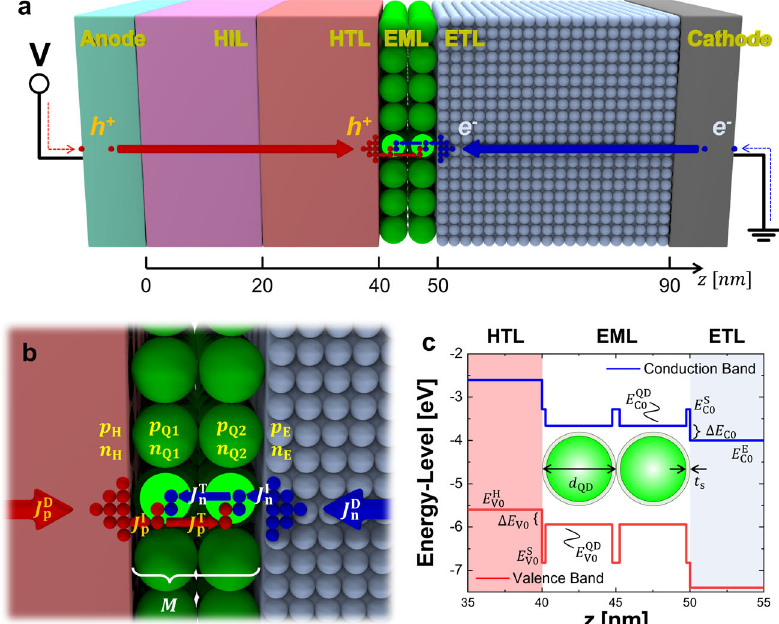
Fig. 1 Device con fi guration of QD-LED for the charge transport simulation. a Schematic illustration of device architecture. An indium tin oxide (ITO), a poly(3,4-ethylenedioxythiophene)/poly (styrenesulfonate) (PEDOT:PSS), a poly[(9,9-dioctyl fl uorenyl-2,7-diyl)-co-(4,4 ′ -(N-(4-sec- butylphenyl)diphenylamine)] (TFB), QDs, a zinc oxide (ZnO) and an aluminium (Al) are used for the anode, HIL, HTL, EML, ETL and cathode, respectively. b Schematic pathways of possible current fl ow around the EML. c Flat-band energy-level diagram across the QD-LED device. E C0QD and E V0QD are the LUMO and HOMO energy-levels of the QD core, and E C0E and E V0H are the conduction and valance band edges of ETL and HTL, respectively. E C0S and E V0S are the conduction and valance band edges of the QD shell, respectively. d QD and t s are the diameter of QD particle and the thickness of the QD shell, dependent capture process and Auger non-radiative recombina- tion are taken into account. With this simulation model, quantitative information on the distribution of charge carrier densities, electrostatic potentials, as well as radiative and non- radiative recombination rates, could be obtained. The electro- optical characteristics, such as luminance, current densities and EQE curves with varying applied voltages, are also analysed by computer simulations from which the key device parameters for high-performance QD-LEDS are identi fi ed. A set of red, green and blue QD-LEDs are fabricated, and their electro-optical character- istics are